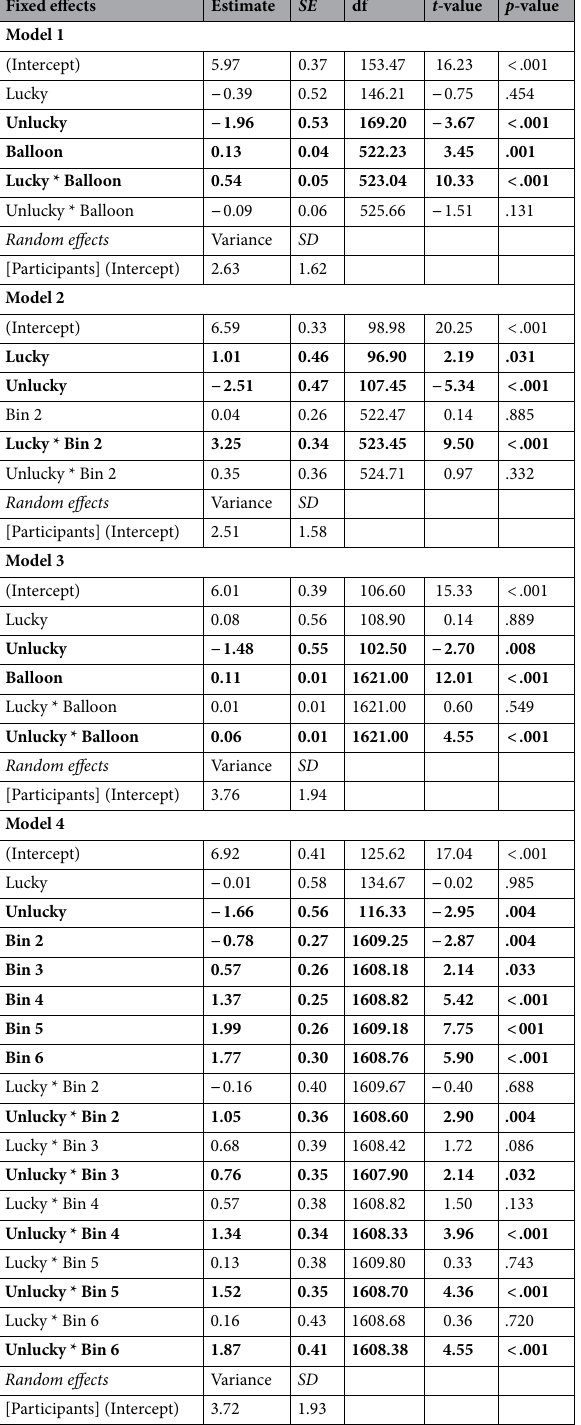
Table 4. Summary of linear mixed-effects models on the number of pumps that did not burst in Experiment 2. Dependent variable in all models: Number of pumps on each balloon that did not burst. Model 1 and Model 2 were fit to the balloons of the initial phase, Model 3 and Model 4 were fit to the balloons of the subsequent phase. For a more detailed description of each model, see main text. With the treatment contrast, the reference level of a given factor was used to estimate the other levels. These were baseline condition and Bin 1. Significant effects are in bold . SE : standard error; SD : standard